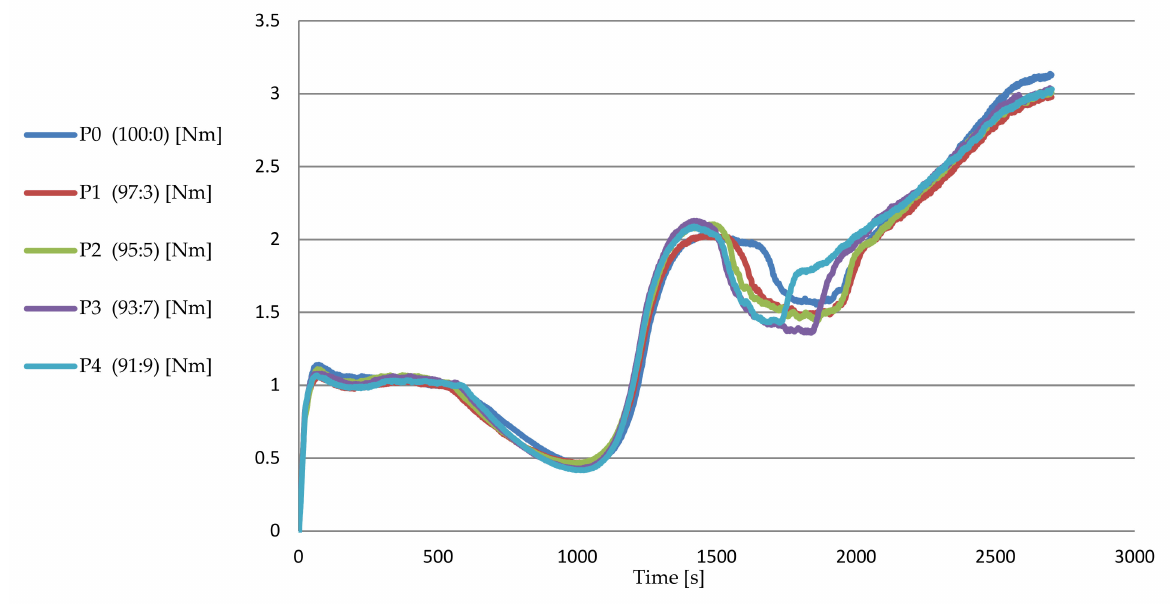
Figure 1. The influence of the substitution level of grape seed flour on the Mixolab